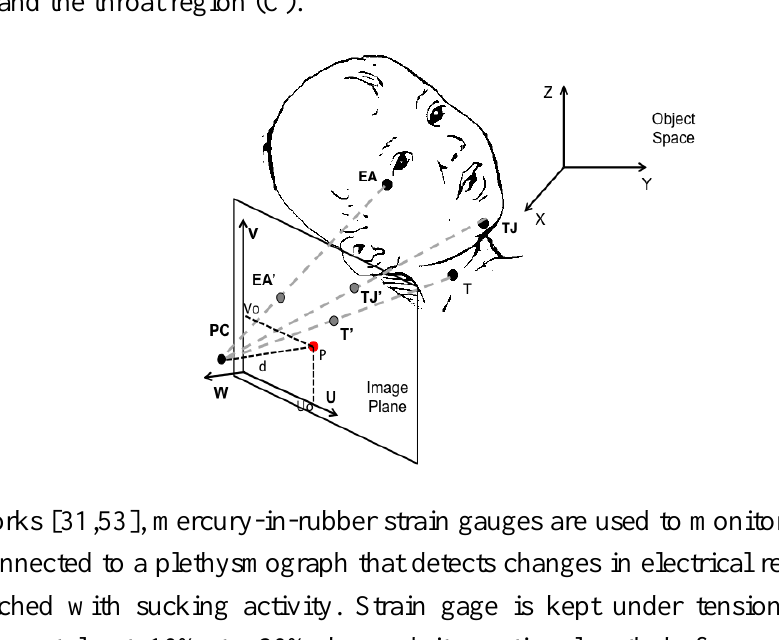
Figure 7. Position of the marker on the throat region, for DLT method application, is determined by first locating three facial markers: the external eye angle (A), the tip of the jaw (B) and the throat region